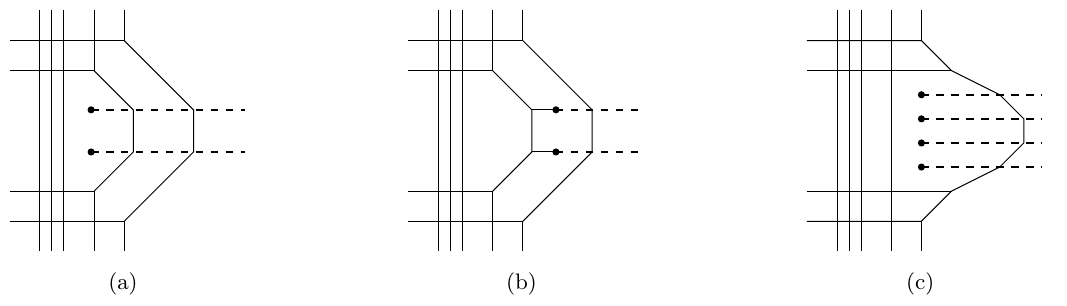
Figure 4 . Figure 4(a) shows a possible 5-brane web corresponding to the class of supergravity solutions illustrated in (cid:12)gure 1(a), with a puncture corresponding to two D7 branes. The brane web shows a general deformation of the SCFT, not the (cid:12)xed point. Figure 4(b) and 4(c) show two options for 5-brane webs with the same external 5-brane charges but 7-branes in a di(cid:11)erent face of the web. The web in (cid:12)gure 4(b) is related to the web in (cid:12)gure 4(a) by 7-brane moves, the web in (cid:12)gure 4(c) is